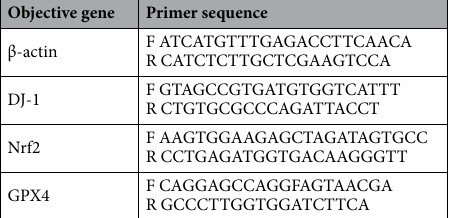
Table 2. Primer information in placental tissue experiment.